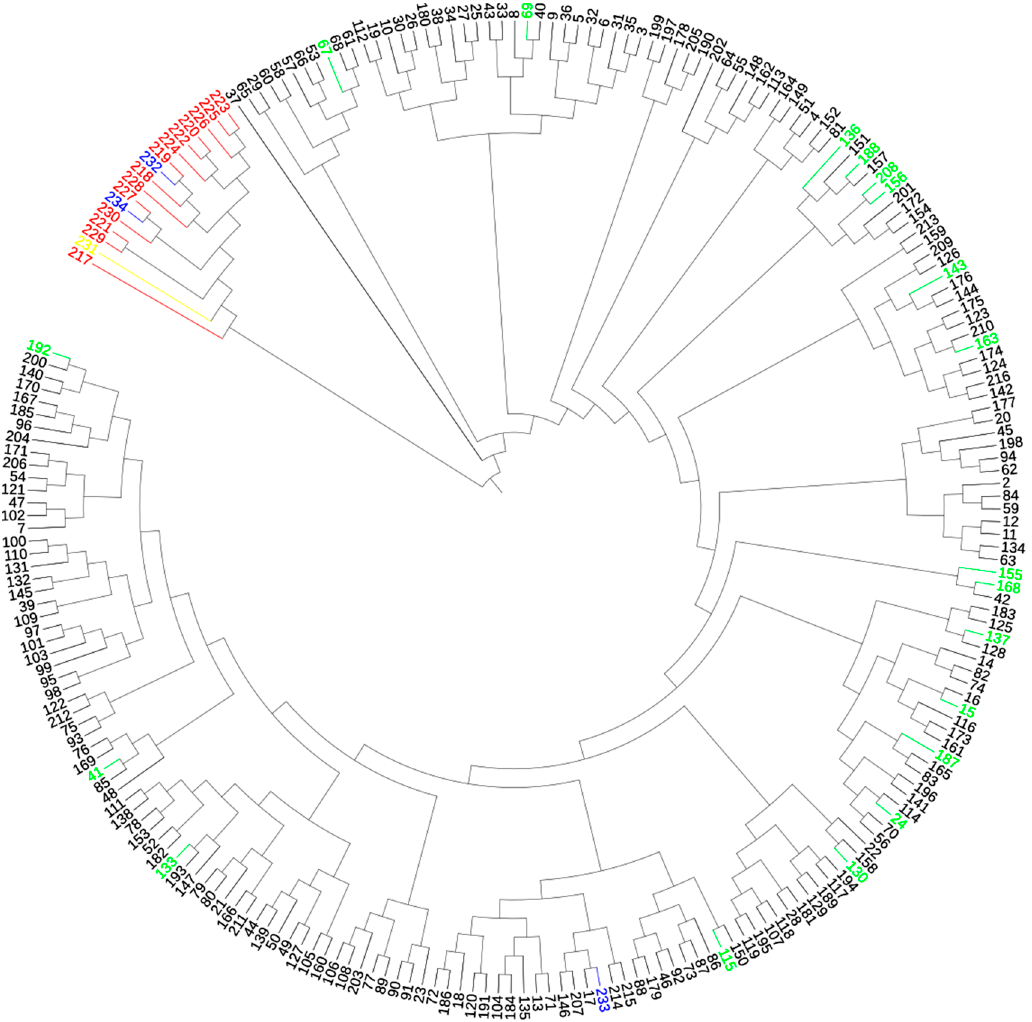
Figure 4. Dendrogram of genetic distance between all individuals by UPGMA algorithm. Black color—alpacas with q ≥ 0.98; red color—llamas with q ≥ 0.98; blue color—three putative hybrids; green color—alpacas with q < 0.98; yellow color—llama with q < 0.98.